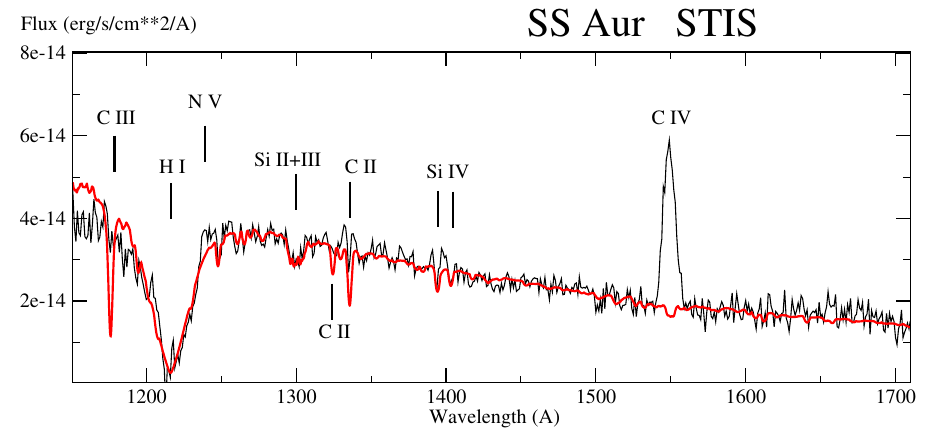
Figure 4. A WD model fit (red line) to the STIS spectrum of SS Aur (in black) obtained at quiescence on 20 March 2003, 34 days after (a different) outburst. The STIS spectrum exhibits strong C IV ( ∼ 1550) emission and weak N V ( ∼ 1240), C II ( ∼ 1335), and Si IV ( ∼ 1400) emission features. The model fit gives: T eff = 31,300 ± 500 K, Log ( g ) = 8.4 ± 0.1, M wd = 0.86 ± 0.07 M (cid:12) . V rot sin ( i ) = 400 ± 50 km/s, and a silicon abundance [Si] = 0.2 ± 0.1 solar. The two spectra were obtained after different outbursts, one year apart, and, consequently, it is not expected that the results will be